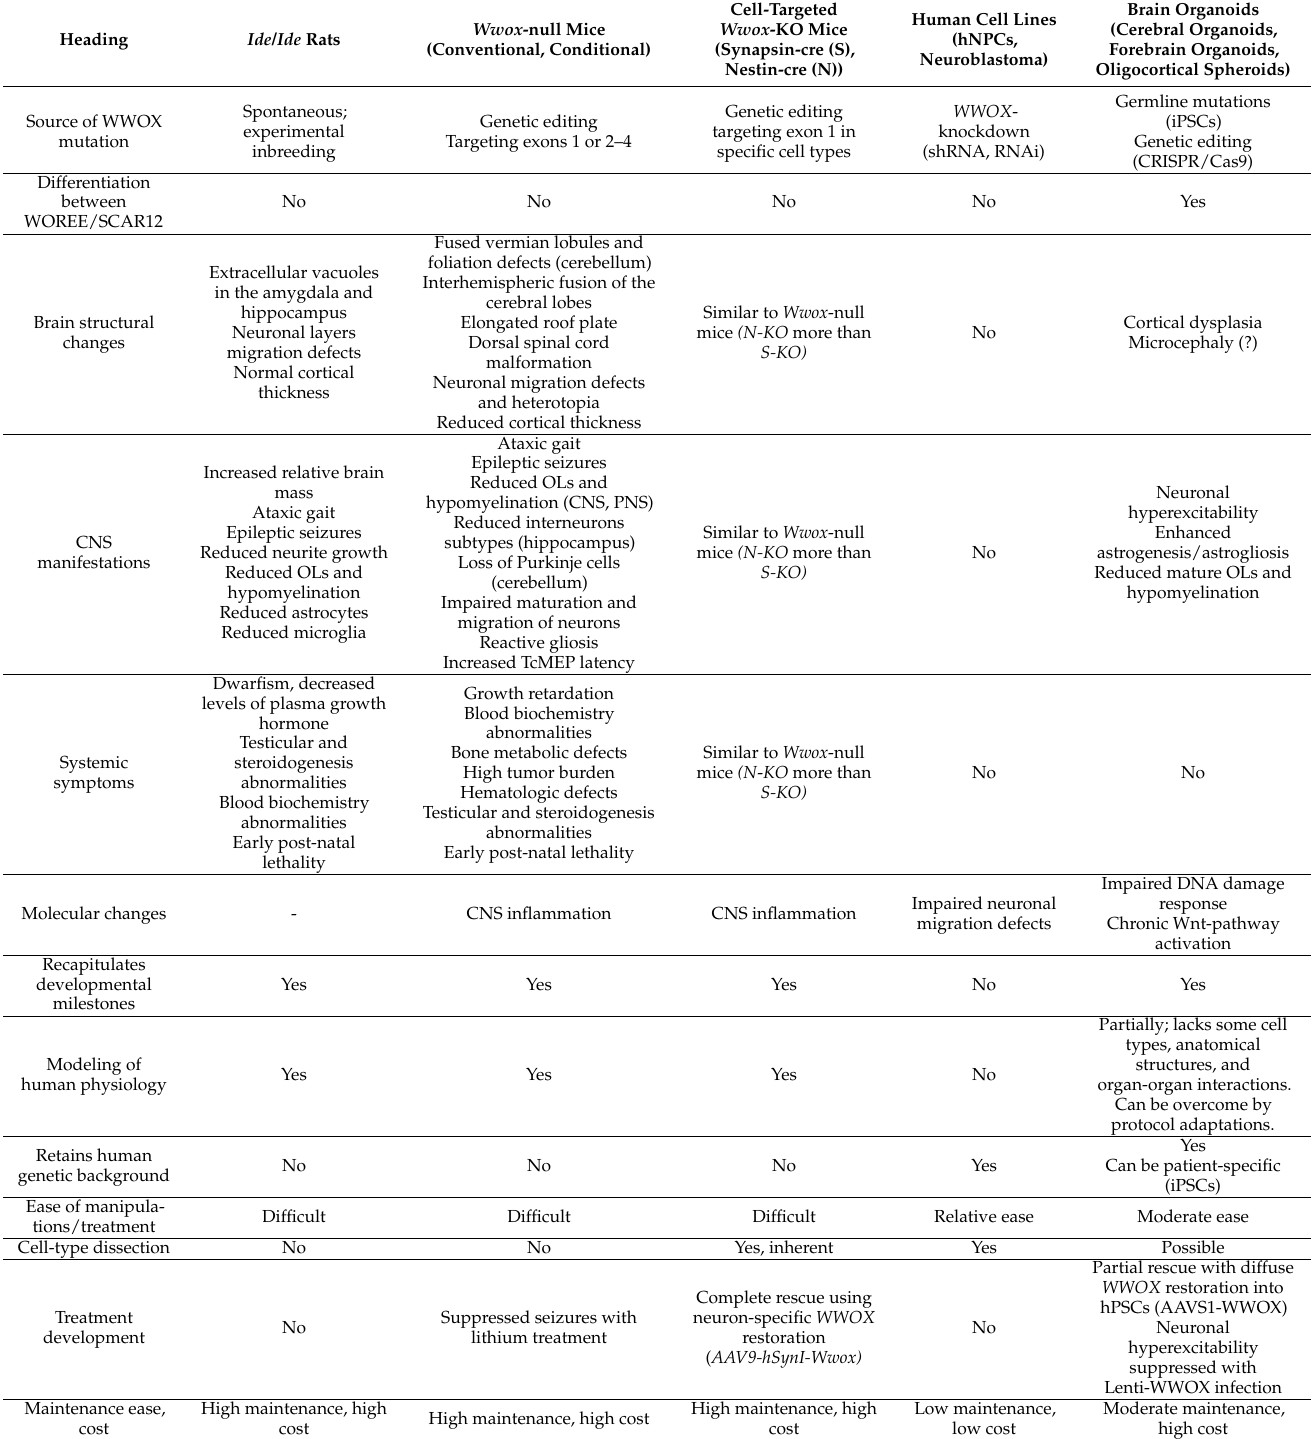
Table 1. Summary of the main models for studying WWOX-related neurodevelopmental